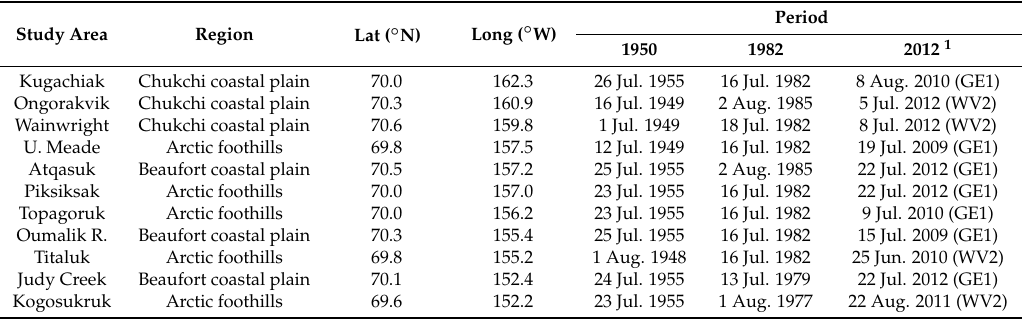
Table 2. Summary of study area locations and dates on which imagery was taken, North Slope, Alaska. Study areas are listed in order from west to east.